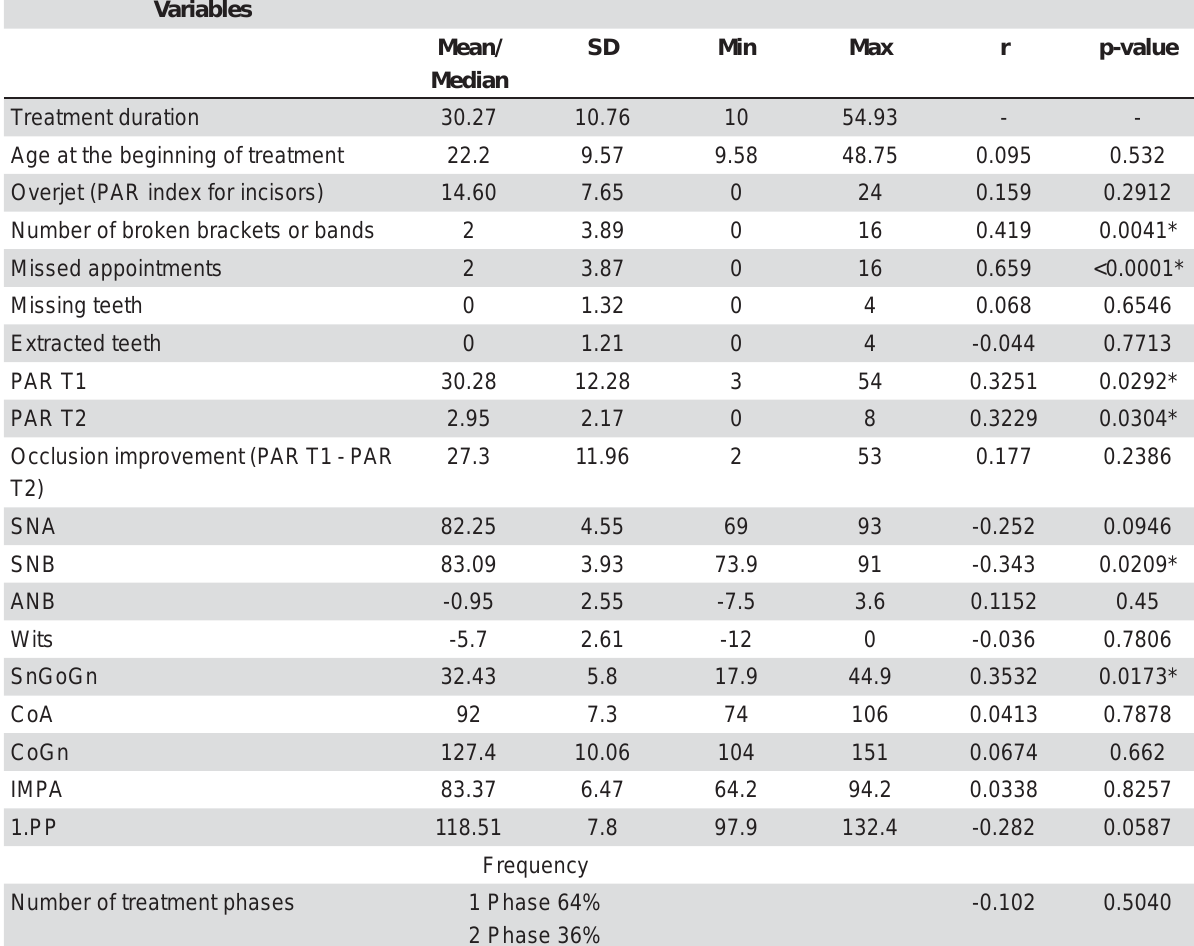
Table 1- (cid:3)(cid:48)(cid:72)(cid:68)(cid:81)(cid:15)(cid:3)(cid:86)(cid:87)(cid:68)(cid:81)(cid:71)(cid:68)(cid:85)(cid:71)(cid:3)(cid:71)(cid:72)(cid:89)(cid:76)(cid:68)(cid:87)(cid:76)(cid:82)(cid:81)(cid:3)(cid:11)(cid:54)(cid:39)(cid:12)(cid:15)(cid:3)(cid:38)(cid:82)(cid:72)(cid:73)(cid:191)(cid:70)(cid:76)(cid:72)(cid:81)(cid:87)(cid:3)(cid:82)(cid:73)(cid:3)(cid:38)(cid:82)(cid:85)(cid:85)(cid:72)(cid:79)(cid:68)(cid:87)(cid:76)(cid:82)(cid:81)(cid:3)(cid:11)(cid:85)(cid:12)(cid:3)(cid:68)(cid:81)(cid:71)(cid:3)(cid:83)(cid:16)(cid:89)(cid:68)(cid:79)(cid:88)(cid:72)(cid:3)(cid:82)(cid:73)(cid:3)(cid:68)(cid:86)(cid:86)(cid:82)(cid:70)(cid:76)(cid:68)(cid:87)(cid:76)(cid:82)(cid:81)(cid:3)(cid:90)(cid:76)(cid:87)(cid:75)(cid:3)(cid:87)(cid:85)(cid:72)(cid:68)(cid:87)(cid:80)(cid:72)(cid:81)(cid:87)(cid:3)(cid:71)(cid:88)(cid:85)(cid:68)(cid:87)(cid:76)(cid:82)(cid:81)(cid:3) for each variable assessed in the